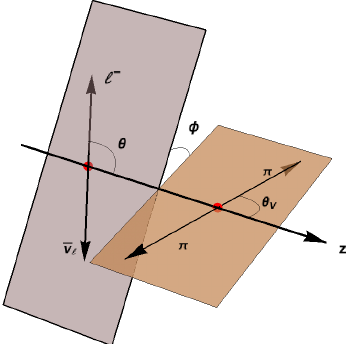
Figure 1. Definition of the angles in the fully differential ¯ B → ρ ( ππ ) (cid:96) − ¯ ν (cid:96) distribution. The ρ → ππ and W − → (cid:96) − ¯ ν (cid:96) decay planes are